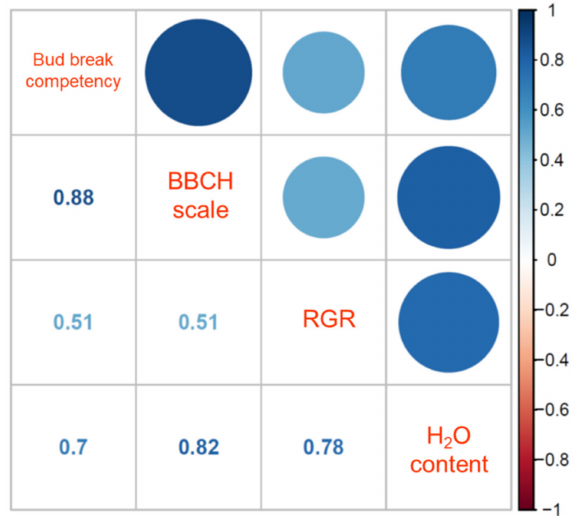
Figure 9. Pearson correlation matrix of traits during dormancy. The color scale reflects the correlation, with 1 indicating a completely positive correlation (dark blue) and − 1 indicating a completely negative correlation (dark red) between two